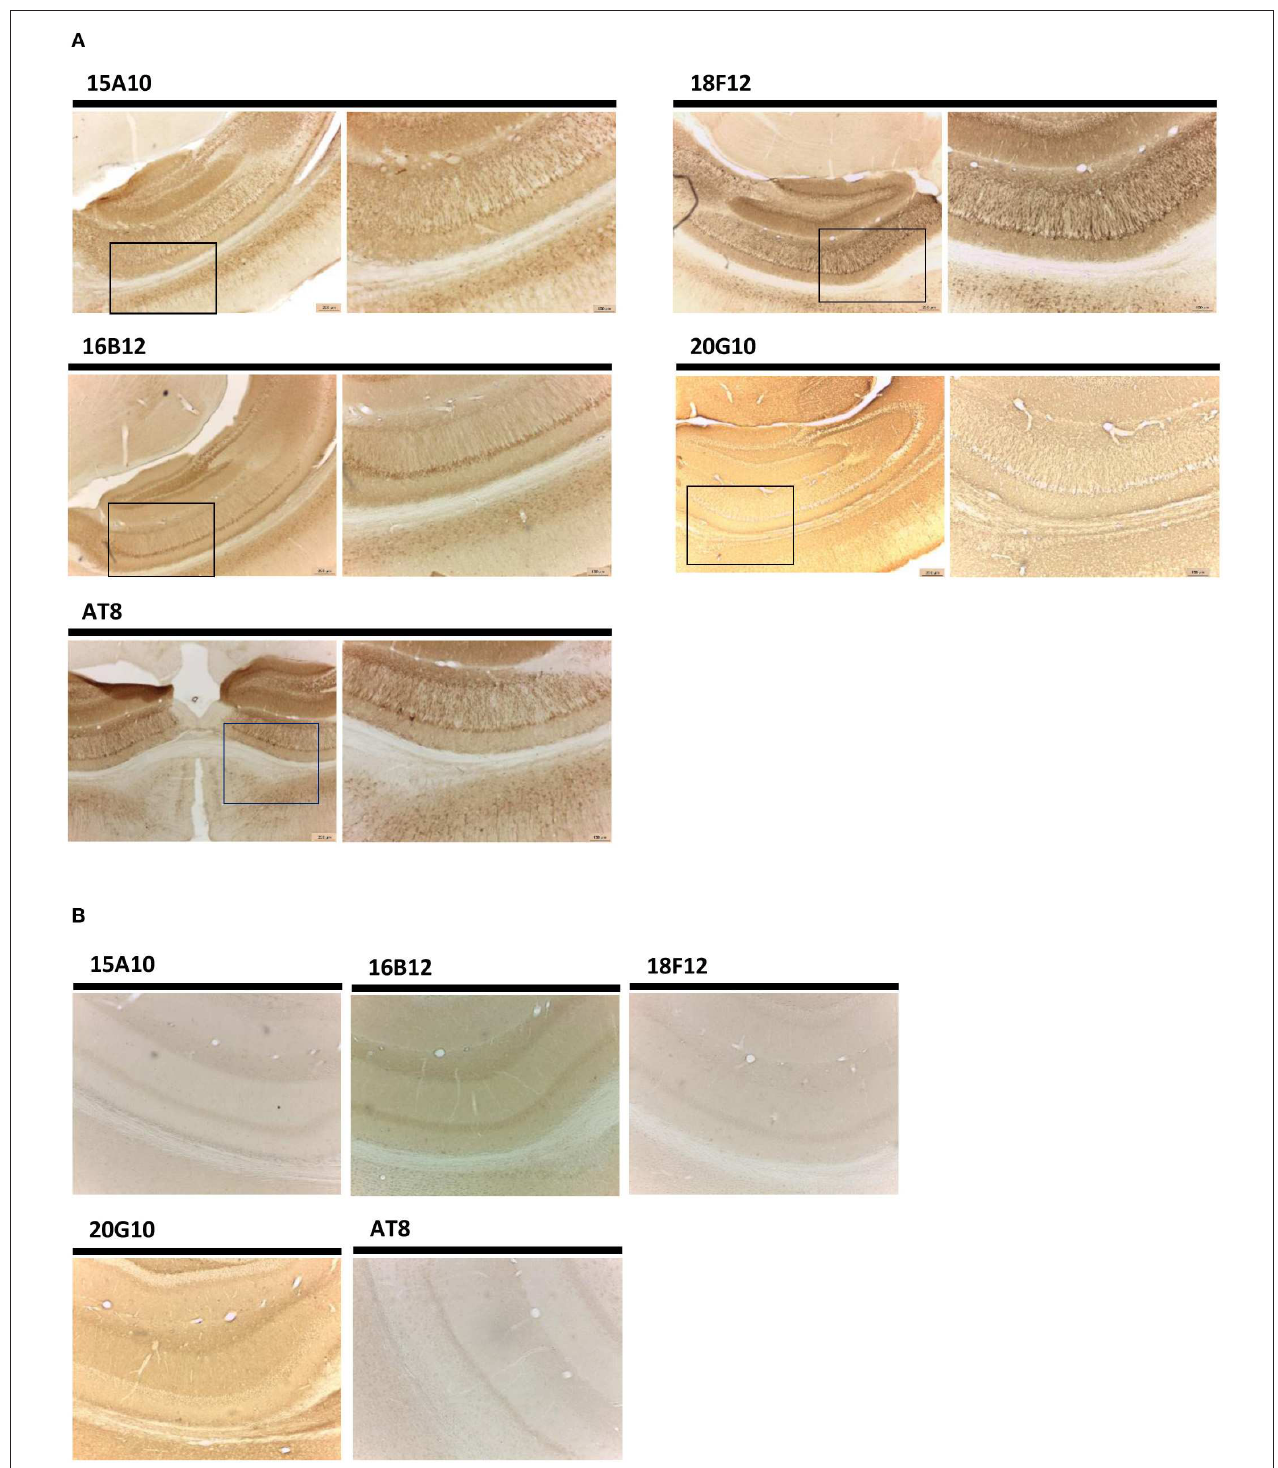
FIGURE 6 | Immunohistochemistry in transgenic mouse hippocampal brain sections. (A) Pictures represent immunohistochemical stainings performed using mAbs 15A10, 16B12, 18F12, and 20G10 on different regions in the hippocampus of Tau1N4R-G272V/P301S mouse brain. AT8 was used as a reference antibody. Lower magnification pictures are shown on the left, while the corresponding higher resolution images are shown on the right. (B) Pictures represent immunohistochemical stainings performed using mAbs 15A10, 16B12, 18F12, and 20G10 on different regions in the hippocampus of wild-type non-transgenic mouse brain. AT8 was used as a reference